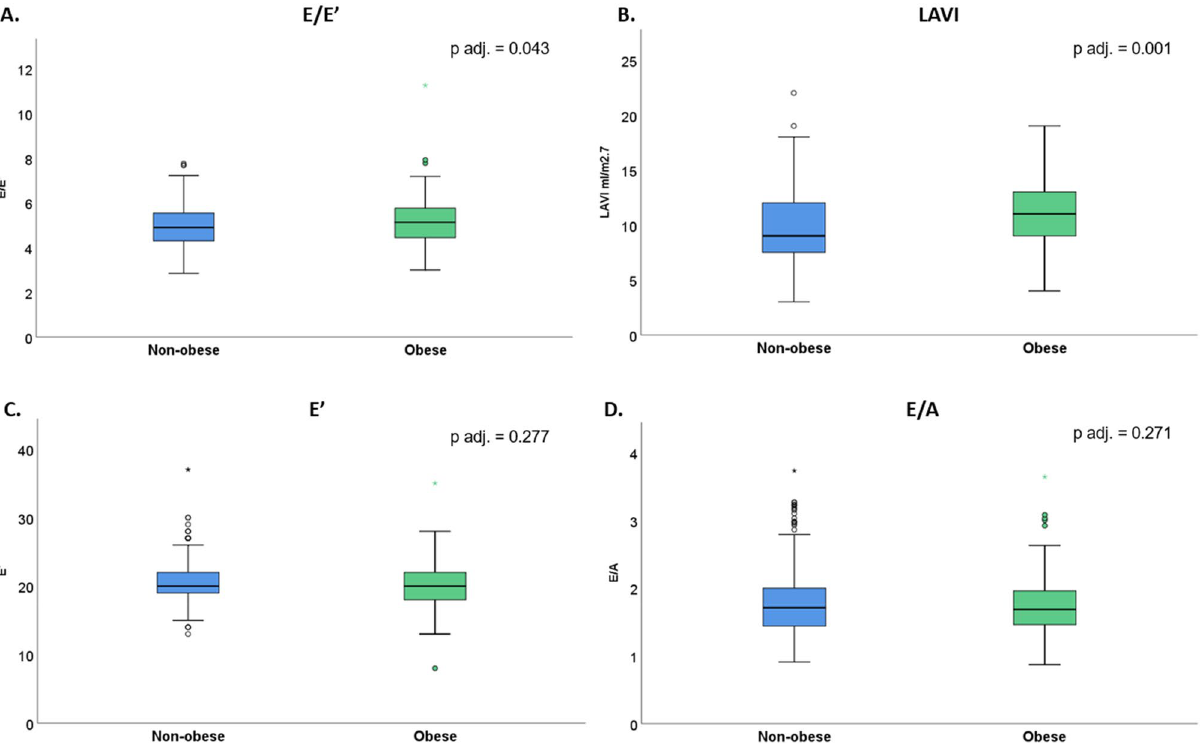
Figure 4. Parameters of diastolic function in obese and non-obese children. ( A ) E/E ′ indicates the ratio between mitral peak velocity of early filling and peak early diastolic tissue velocities of mitral annulus. ( B ) Left atrial volume indexed to height. ( C ) E ′ indicates peak early diastolic tissue velocities of mitral annulus. ( D ) E/A indicates the ratio between mitral peak velocity of early diastolic filling and atrial